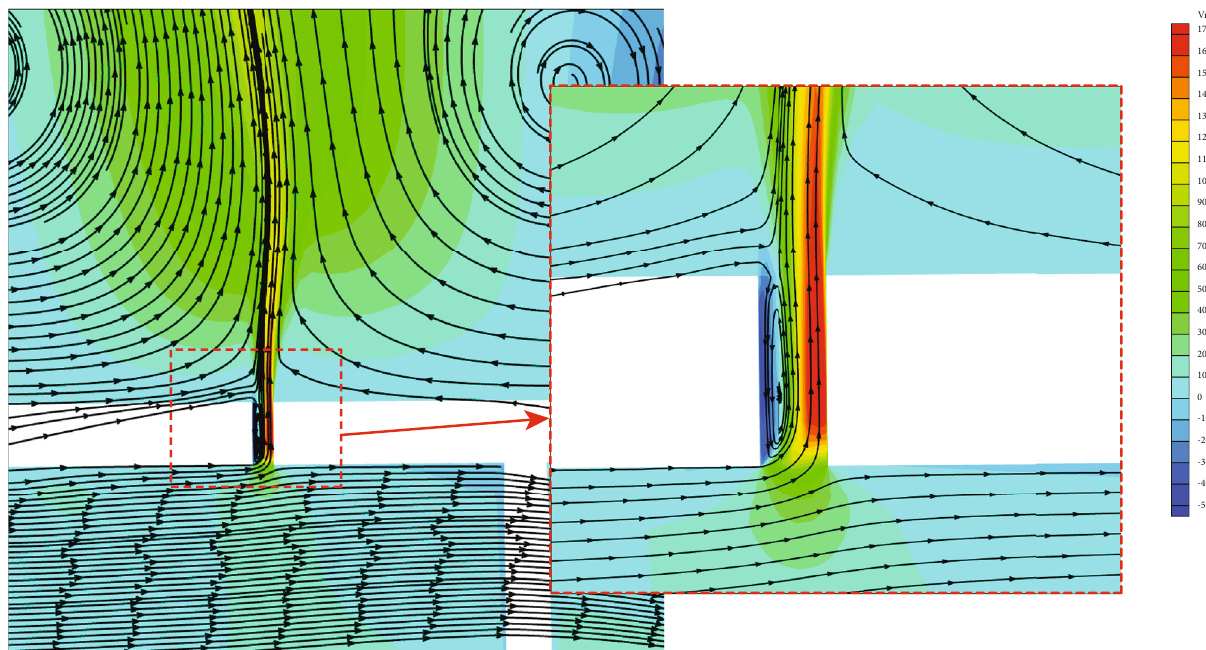
Figure 8: Flow characteristics near the